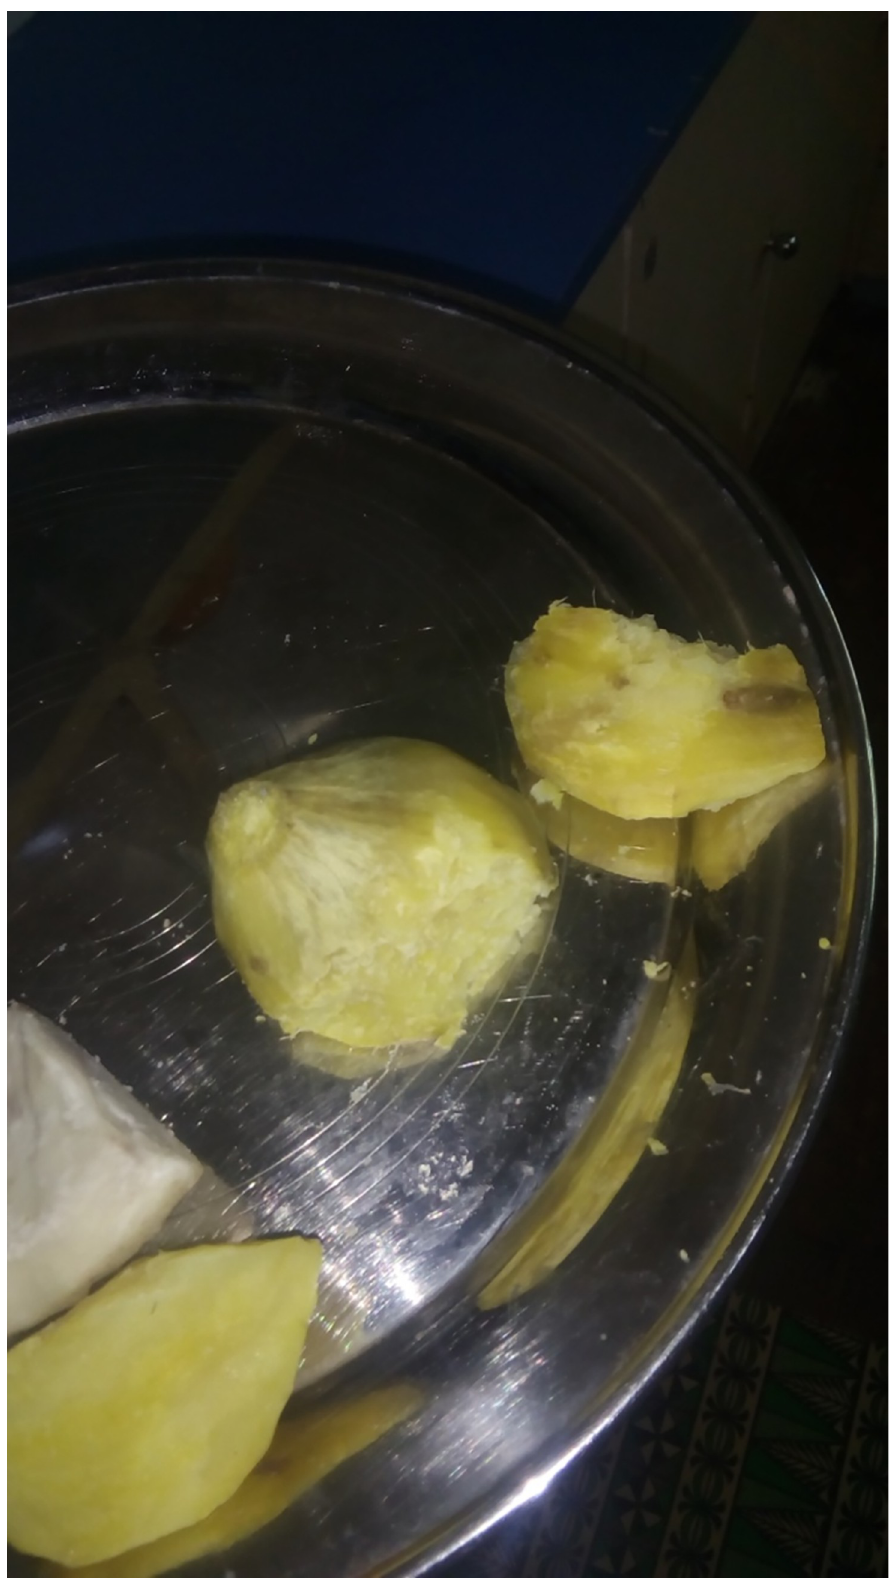
Fig 7. PhP4 (The potato and the